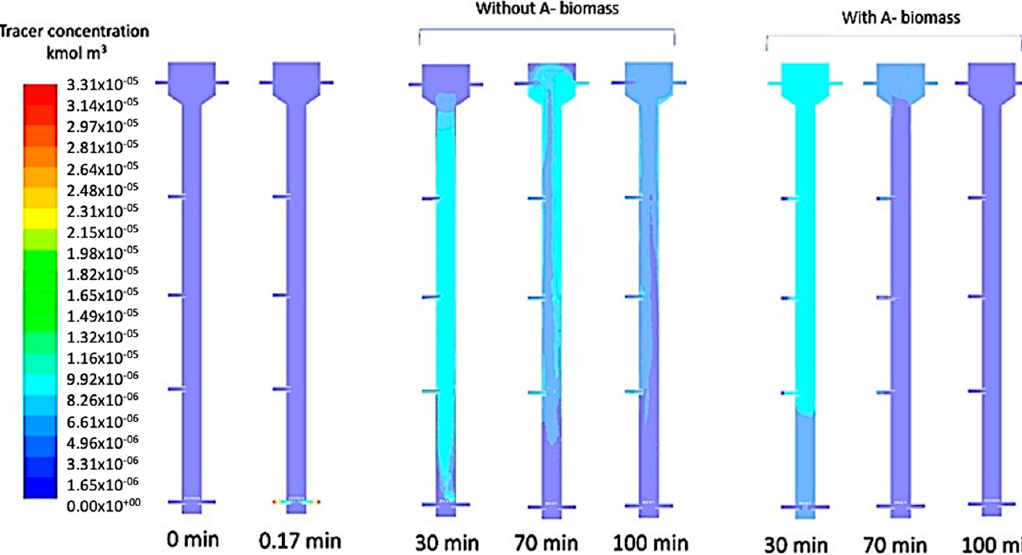
Figure 4. Spatial and temporal distribution of the tracer concentration in the tubular reactor with and without A-biomass at a v s of 0.65 m h − 1 and at an HRT of 7.2 h.